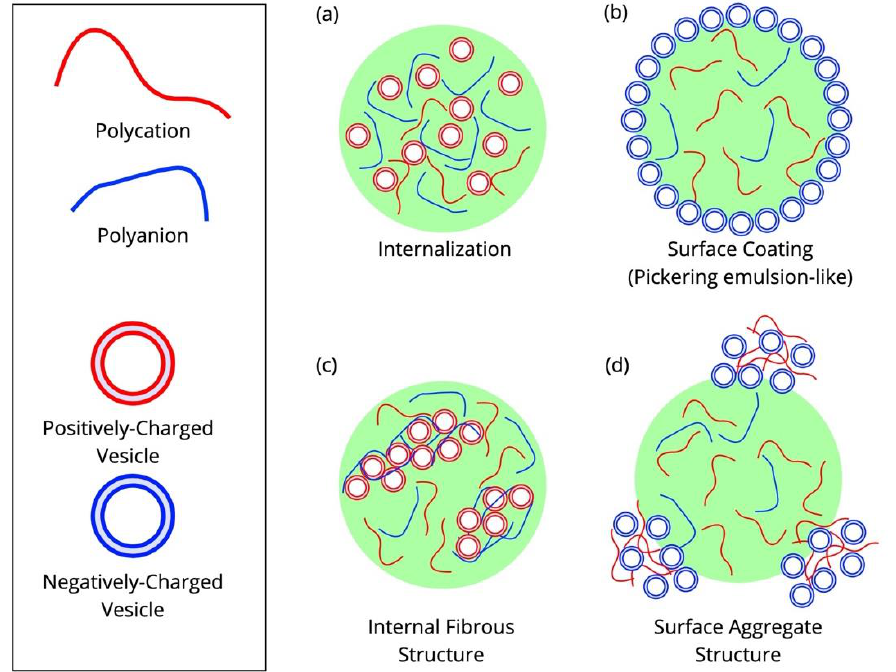
Figure 4. Different observed arrangements of vesicles within or around a complex coacervate. These are illustrative examples; these spatial arrangements are not definite based only on the charge of the components present. Vesicles can ( a ) be internalized within a coacervate, ( b ) coat the surface of the coacervate, ( c ) form a fibrous internal structure with a coacervate component, and ( d ) form aggregates with a coacervate component at the coacervate surface.